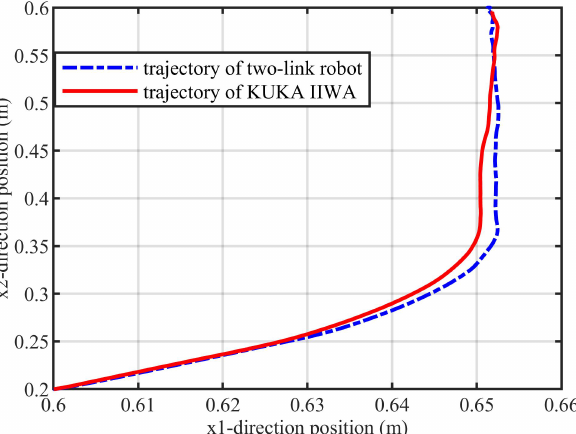
Figure 10. Trajectory of end-effector of two-link robot and KUKA IIWA robot.